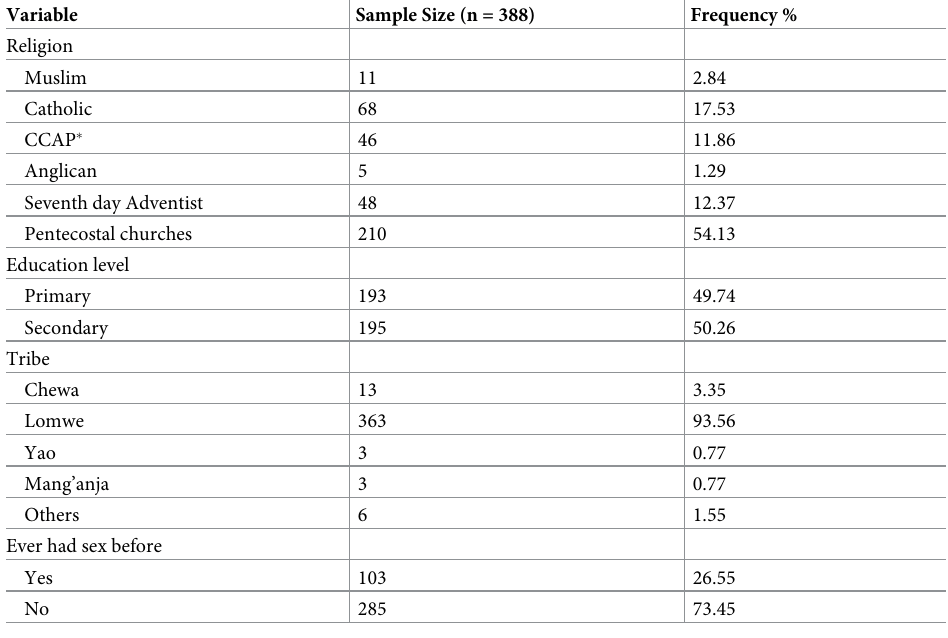
Table 1. Demographic characteristics of the study